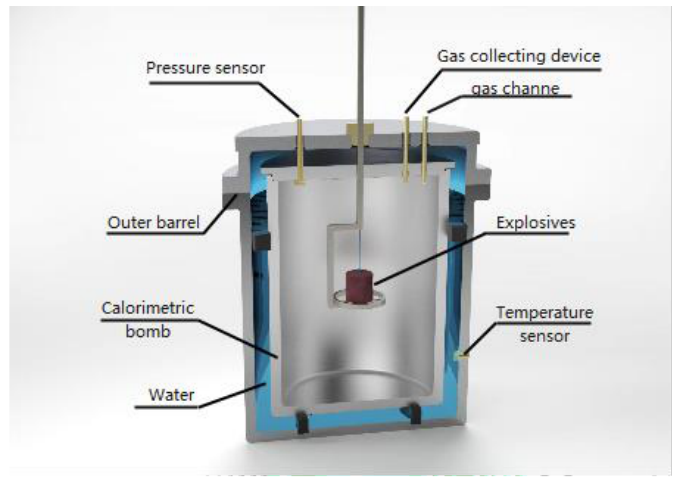
Figure 2. Schematic illustration of a calorimetric bomb. In the pressure measurement test, the voltage–time signal was obtained by the pressure sensor, and the high-frequency component of the shock wave was filtered out by the filter module, to realize the direct measurement of the low-equilibrium pressure. The pressure sensor adopted the Kunshan dual-bridge CYG400 high-frequency dynamic piezoresistive pressure sensor with a range of 6 MPa and an accuracy of 0.5. Among them, the